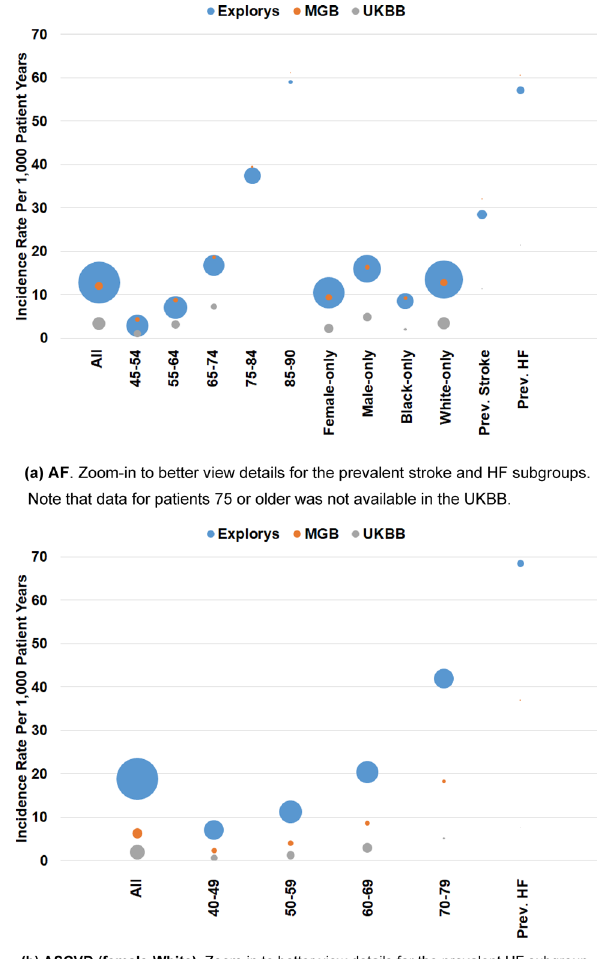
Figure 1. Incidence rates per 1 K PY and population sizes. All population and subpopulation sizes and exact incidence rates are provided in Supplementary Table IX.